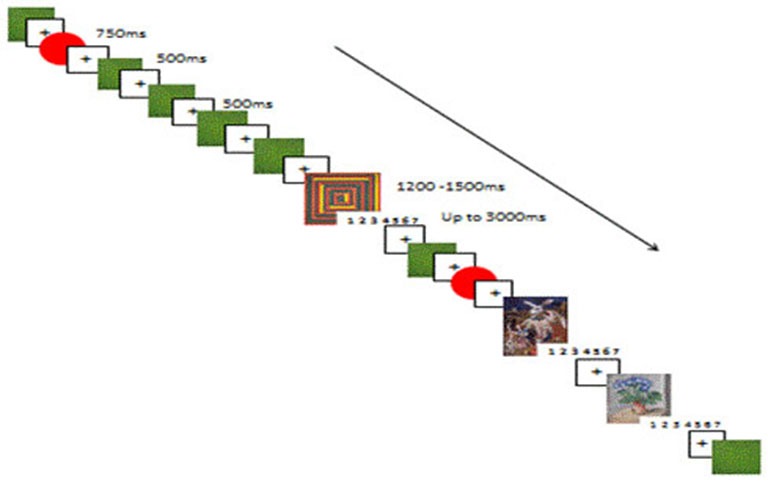
A reproduction of the experimental paradigm, showing the succession of target (1200–1500 ms), frequent (500 ms) and rare (750 ms) non-target stimuli, and fixation cross (500 ms). After each target stimuli the rating screen appeared for up to 3000 ms, during which time participants had to give the target stimuli a visceral affective rating (from 1–7).